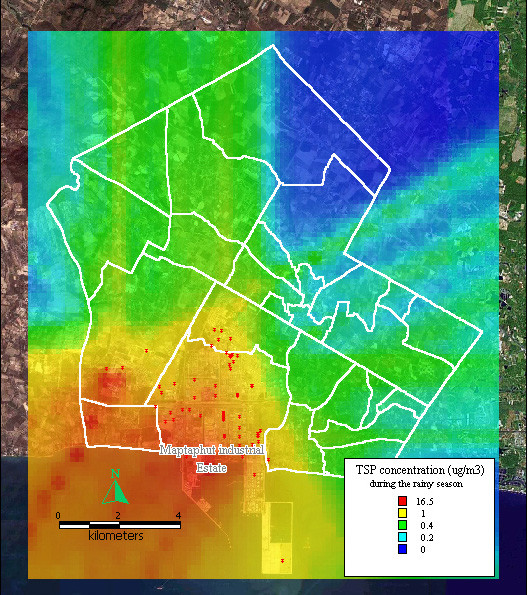
Dispersion of TSP during the rainy season. Red dots indicate the stacks that released total suspended particle.